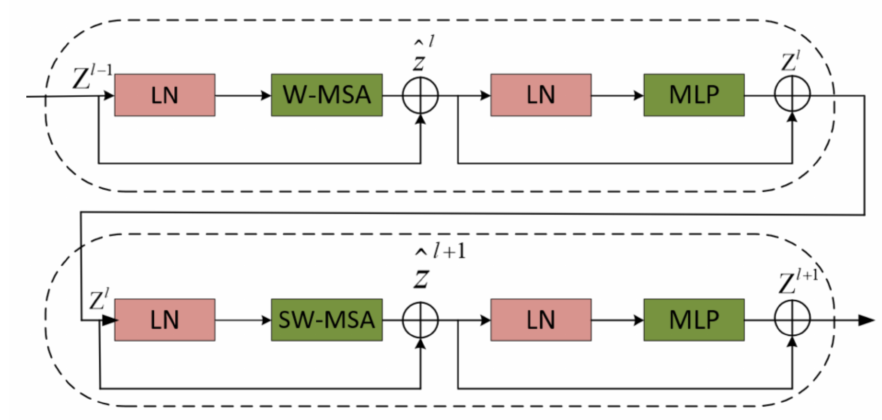
Figure 3. Swin transformer block.